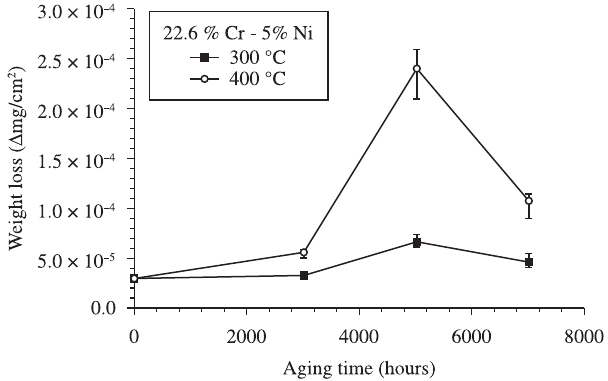
Figure 2. Weight loss (g.cm –2 ) as a function of aging time. Solution: 1.7 M FeCl for 200 hours. 3